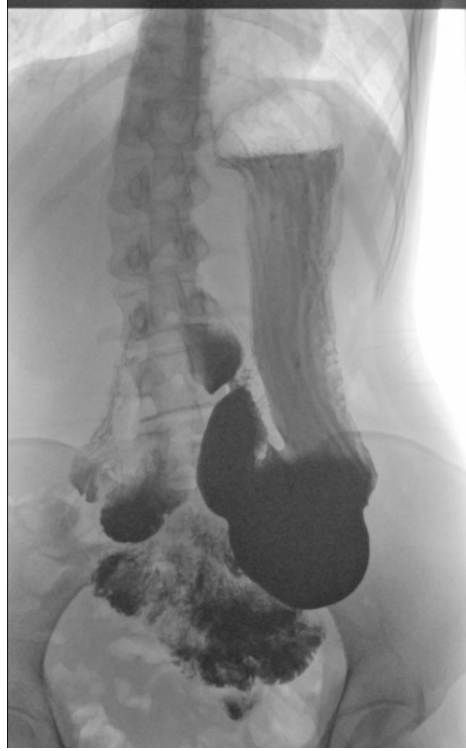
Figure 1. The stomach and duodenum clearly visible in an upper GI X ‐ ray using barium in upright position. The greater curve is reaching downward to the sacrum. Please note the retention of barium contrast in the stomach.